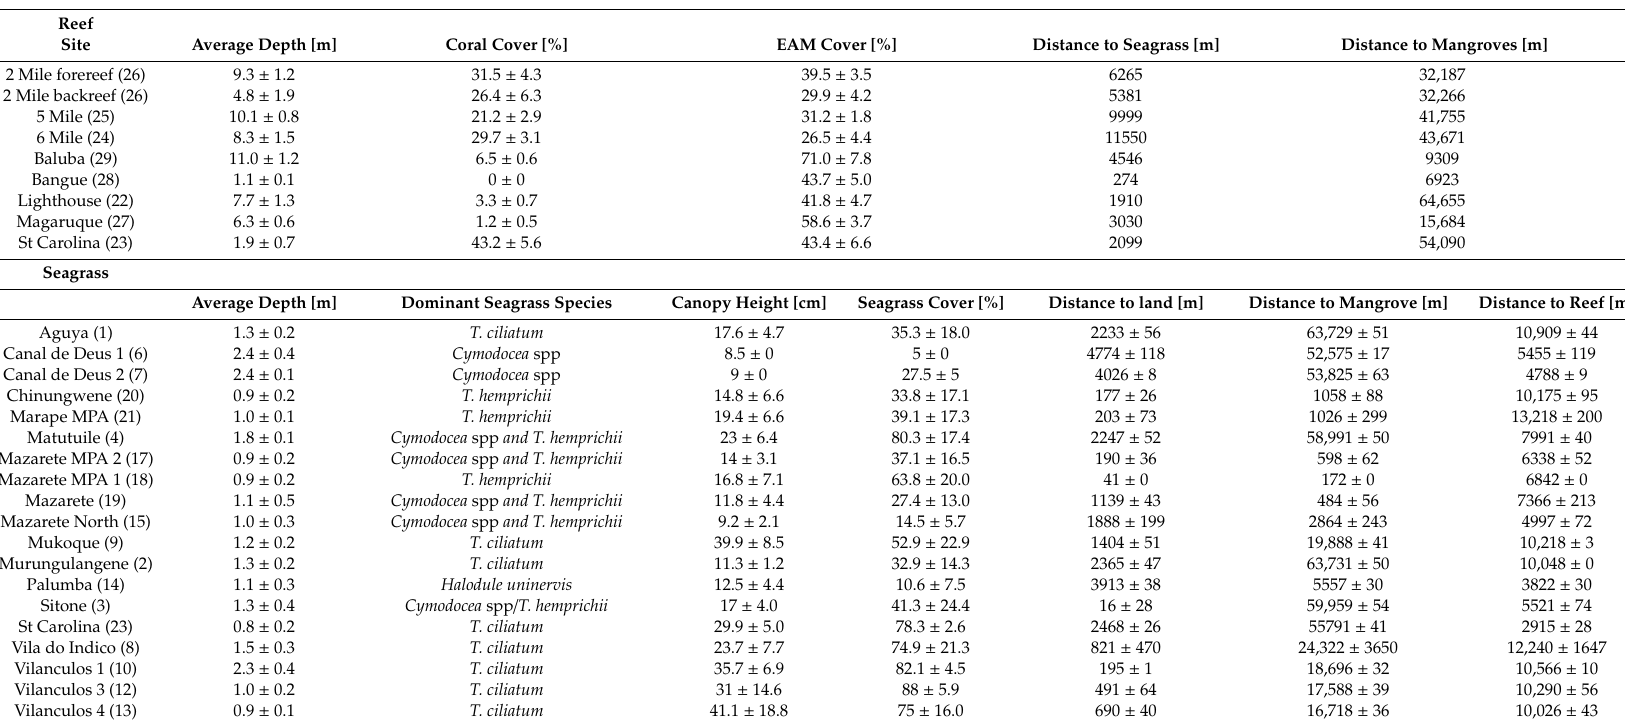
Table A1. Spatial metrics and habitat characteristics of the surveyed reefs and seagrass meadows ± standard error. Numbers in parentheses refer to numbers in Figure 1. Reef Site Coral Cover [%] EAM Cover [%] Distance to Seagrass [m] Distance to Mangroves